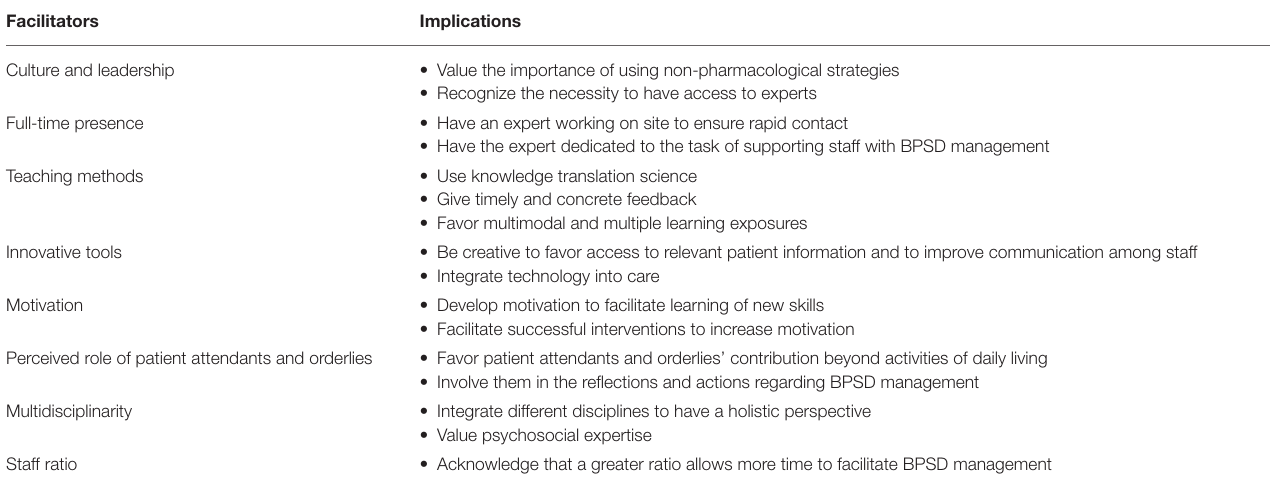
TABLE 1 | Facilitators identified in the management of BPSD and concrete implications.